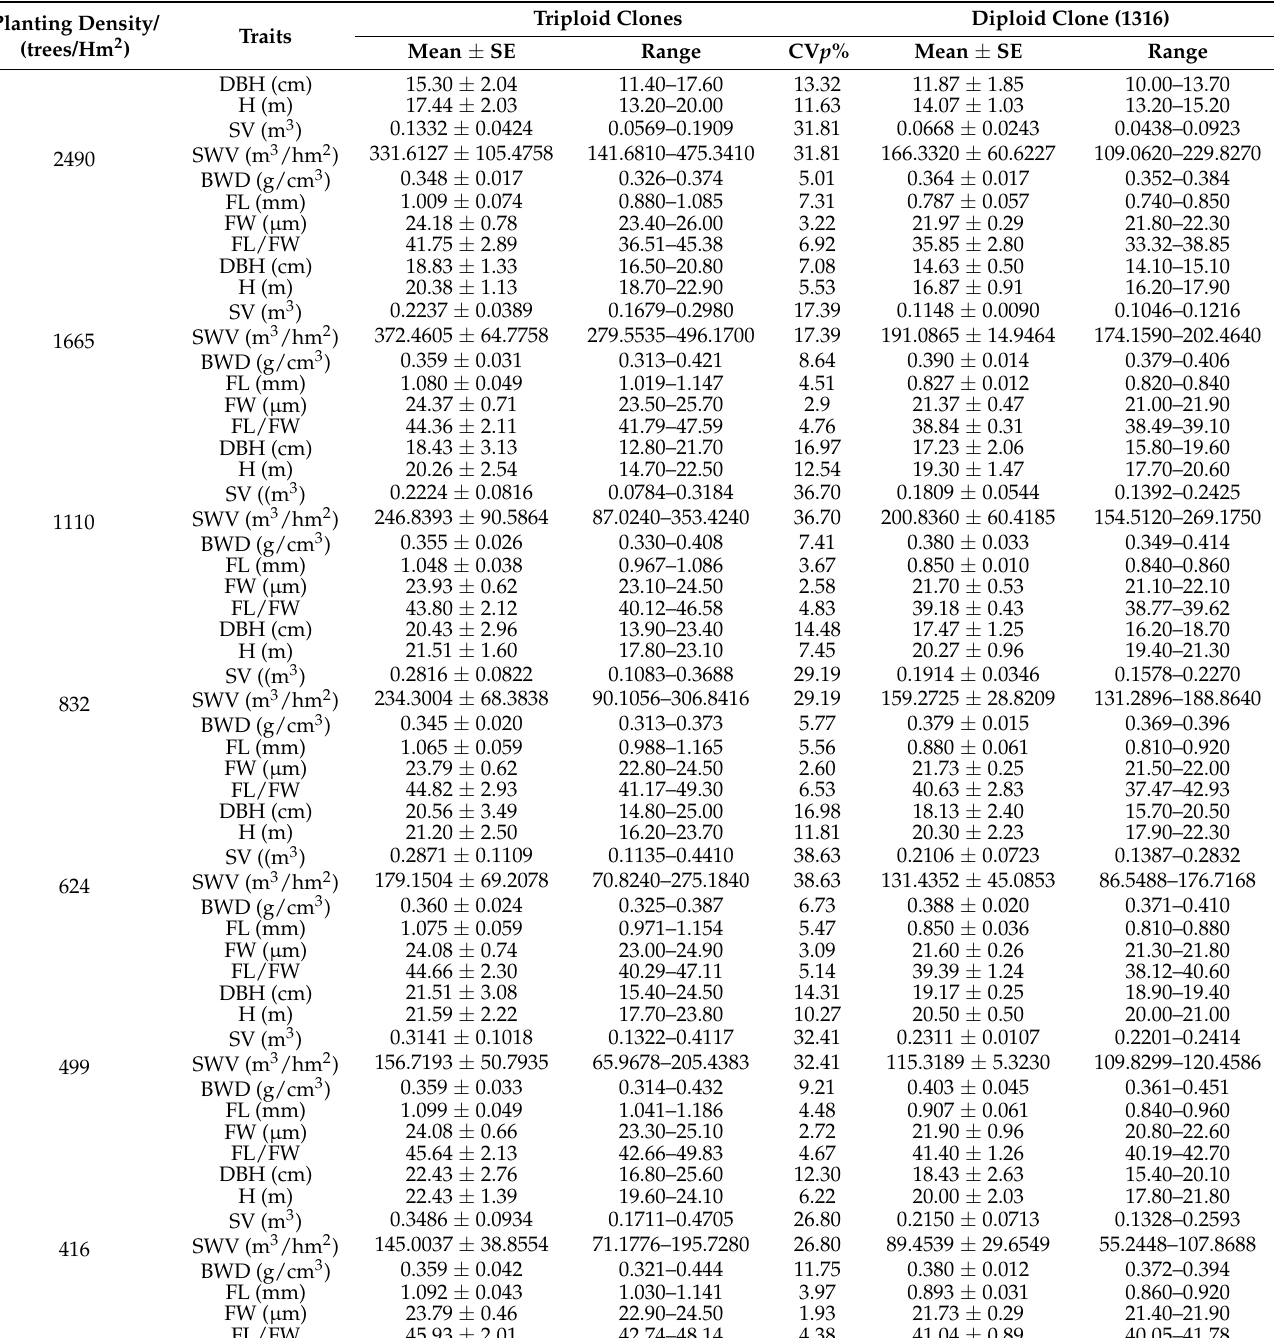
Table 2. Clone mean ( ± SE), range of variation and coefficients of phenotypic variation (CV p %) of growth traits, BWD, and fiber properties at seven initial planting